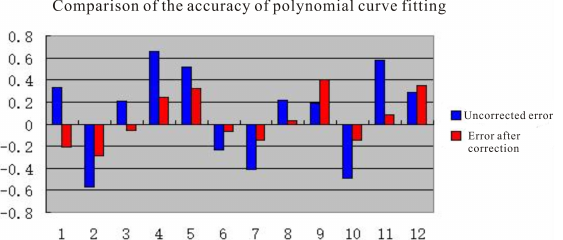
Figure 6 Comparison of polynomial curve fitting accuracy